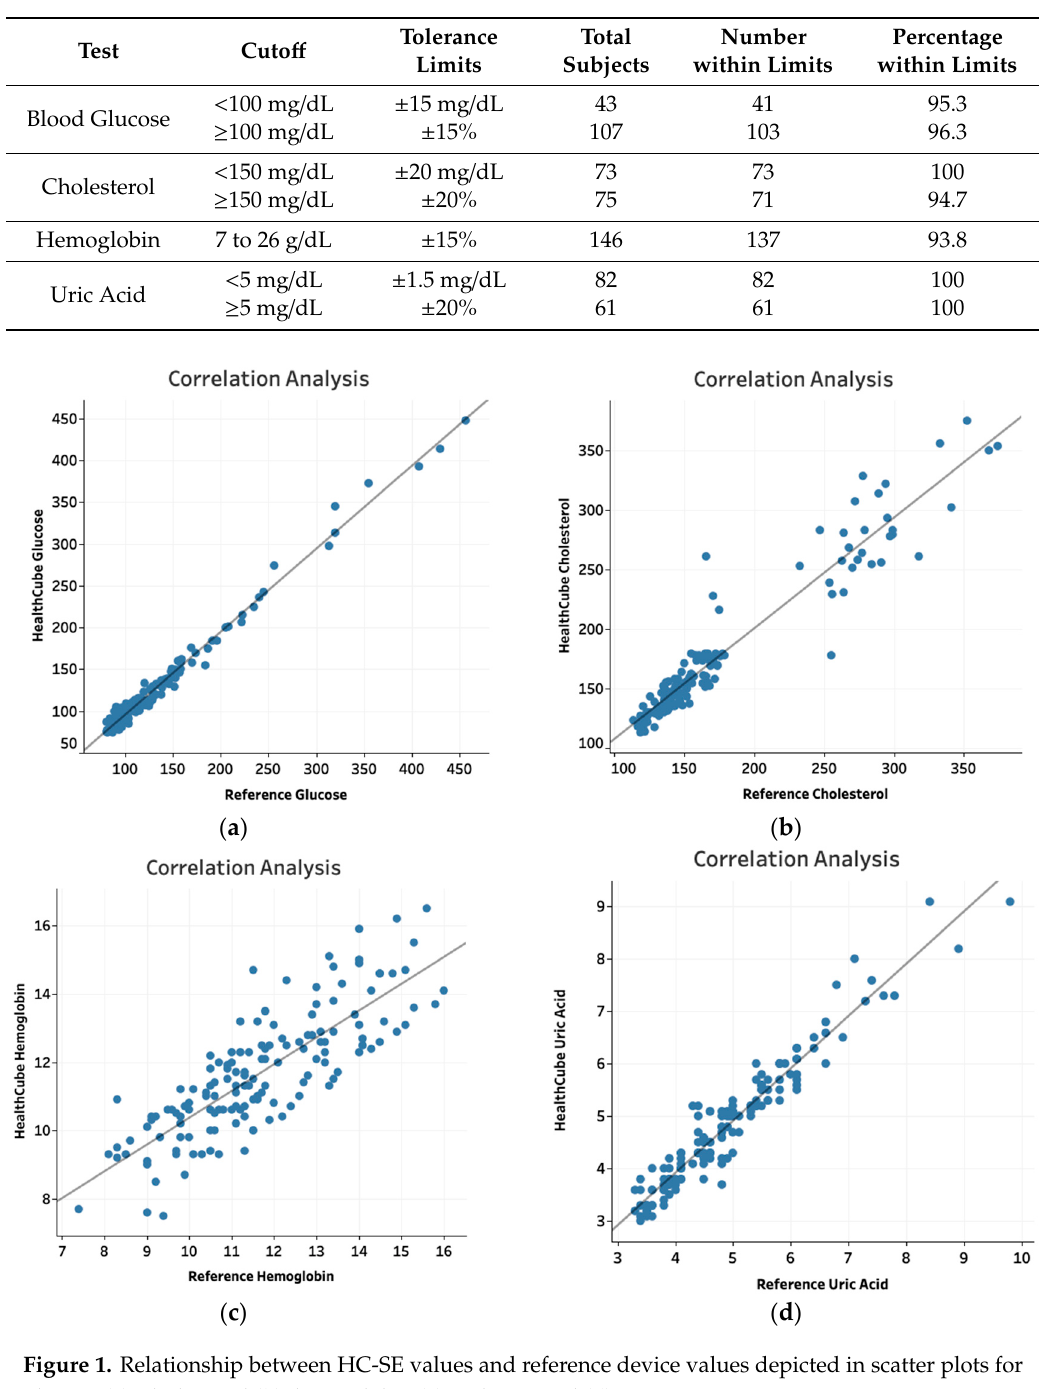
Table 4. Fit of data within specific ranges for blood glucose, cholesterol, hemoglobin and uric acid.